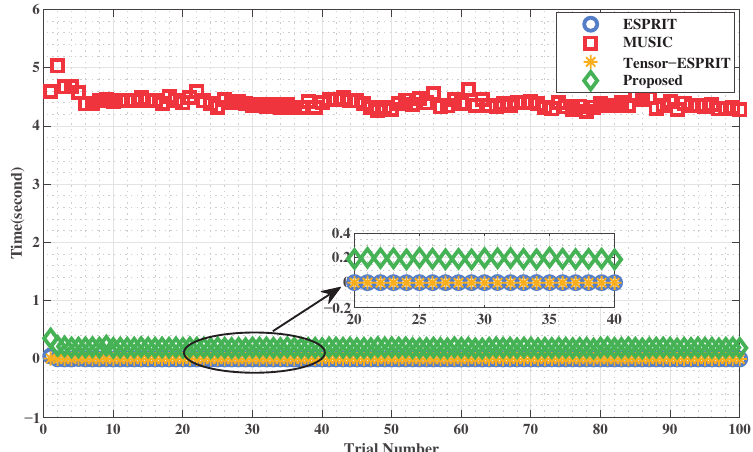
Figure 11. The simulation running time